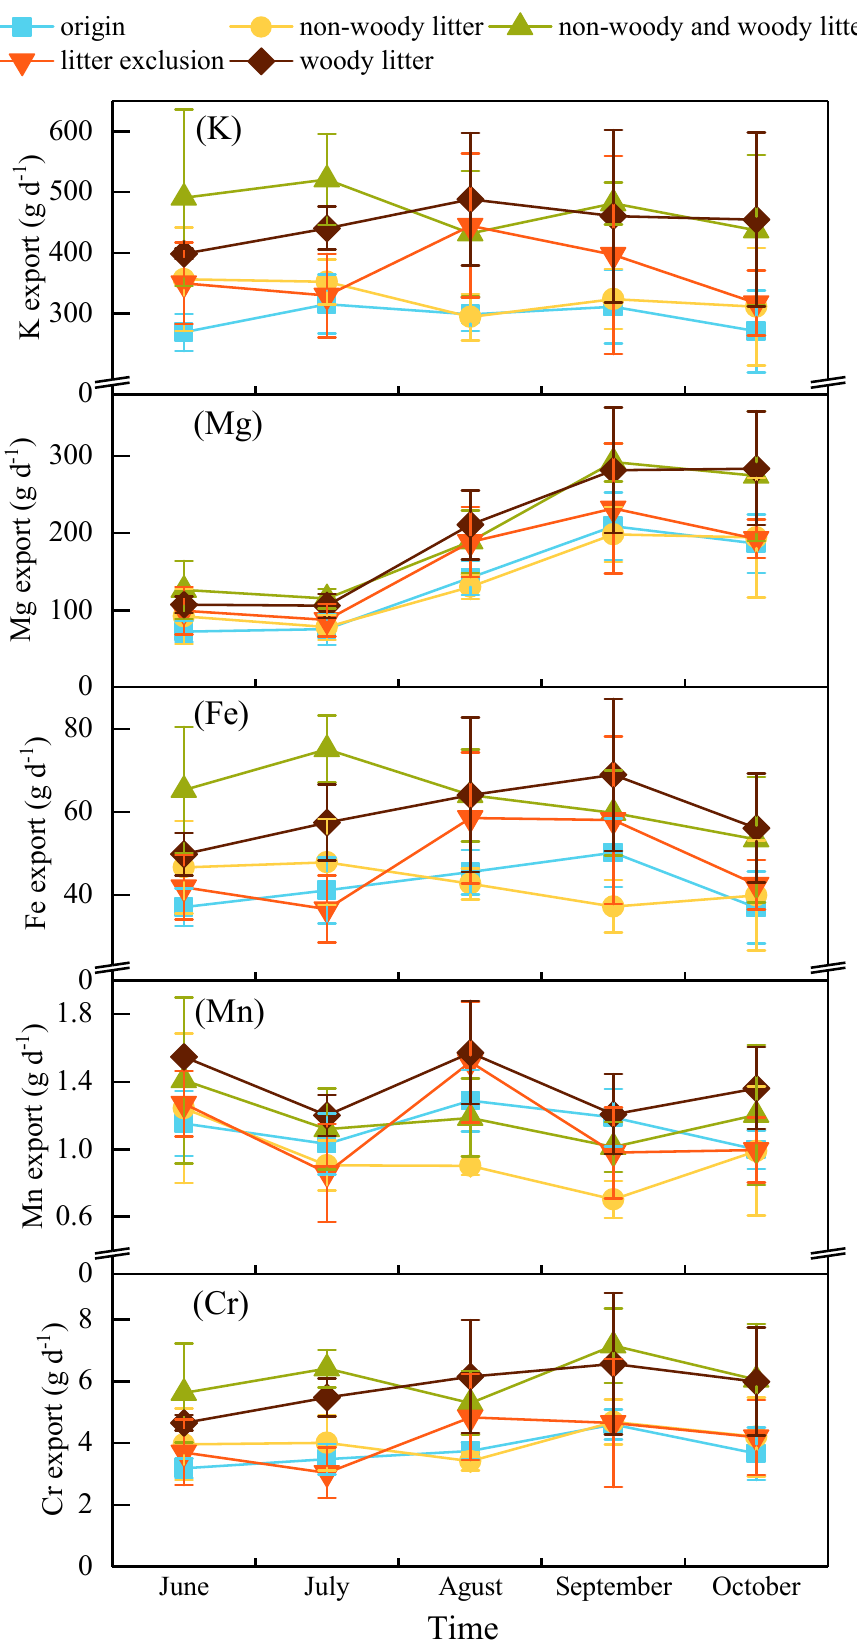
Figure 3. The K, Mg, Fe, Mn and Cr export of the water in the stream with different plant litter input conditions.